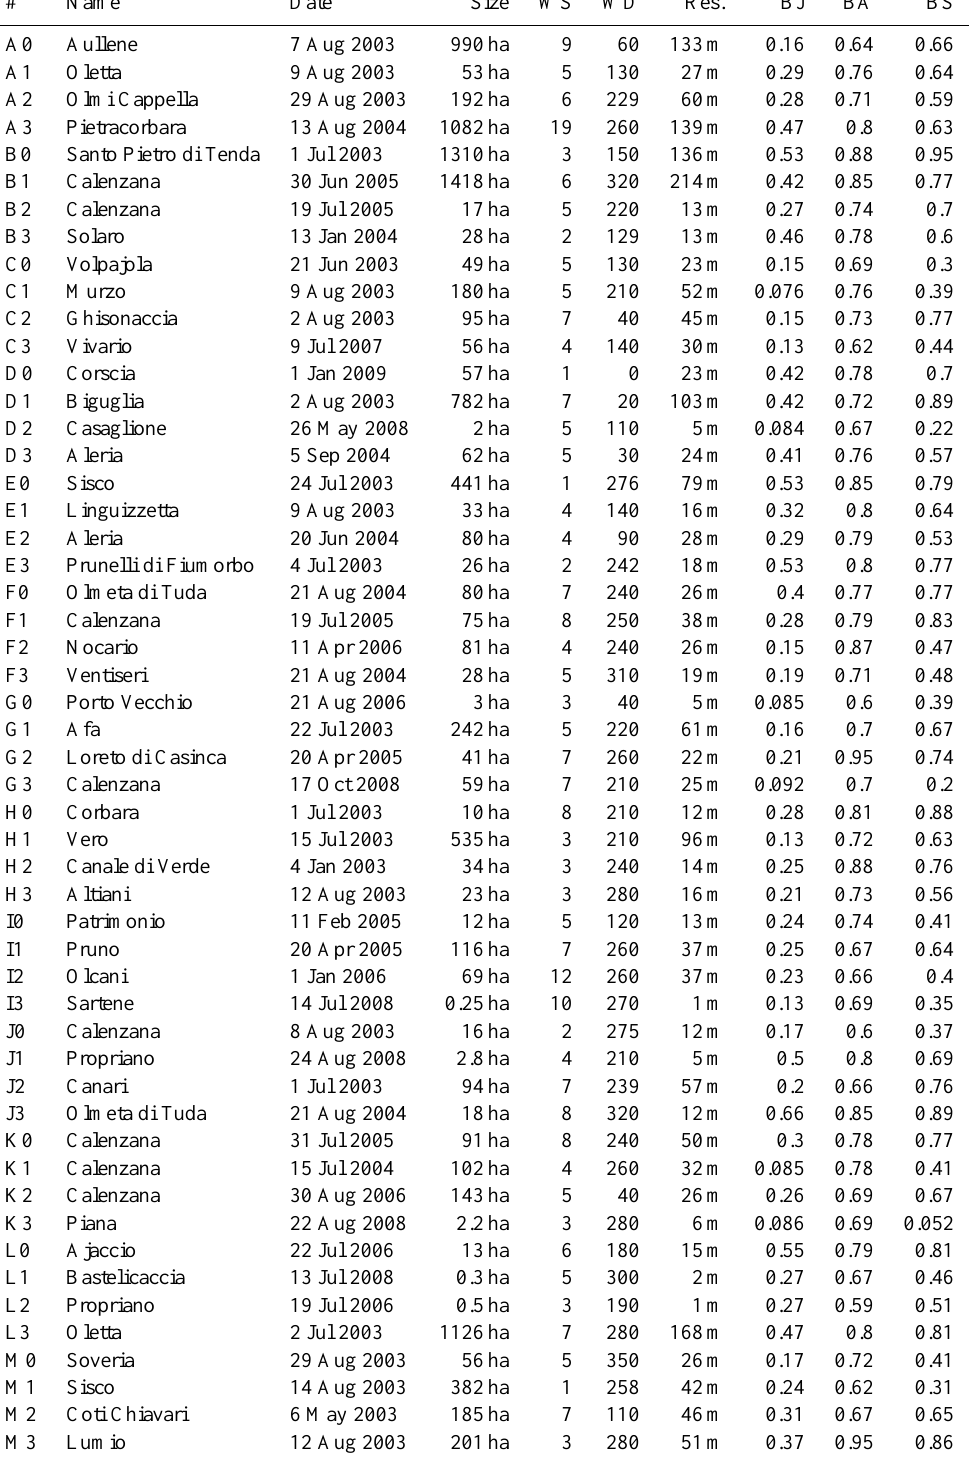
Table A1. Information about all the 80 fires shown in Figs. A1–A3. The size is the final burned area in hectares. WS stands for wind speed, in ms − 1 . WD is the wind direction in degrees, defined clockwise, with 0 corresponding a westerly wind (90 southerly). The resolution in metres is in column “Res.”. The final three columns represent the best scores (among the four models) found for Jaccard similarity coefficient (BJ), arrival time agreement (BA) and shape agreement